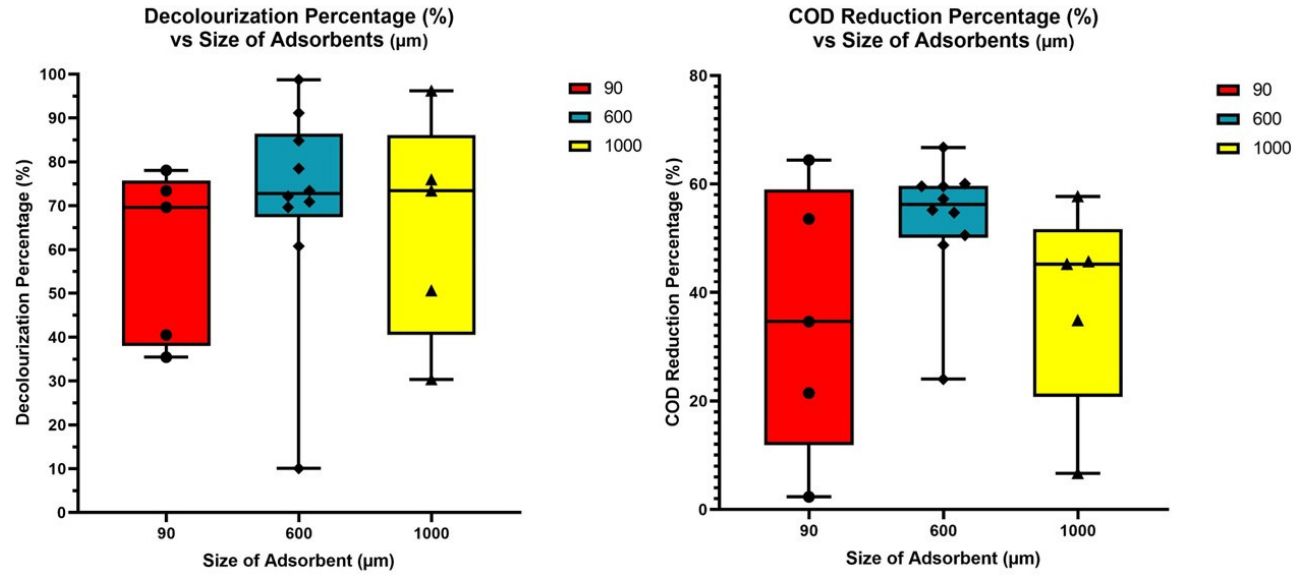
Figure 8. The decolourisation percentages ( left ) and COD reduction percentages ( right ) of RTDW based on the size of adsorbents in μm.